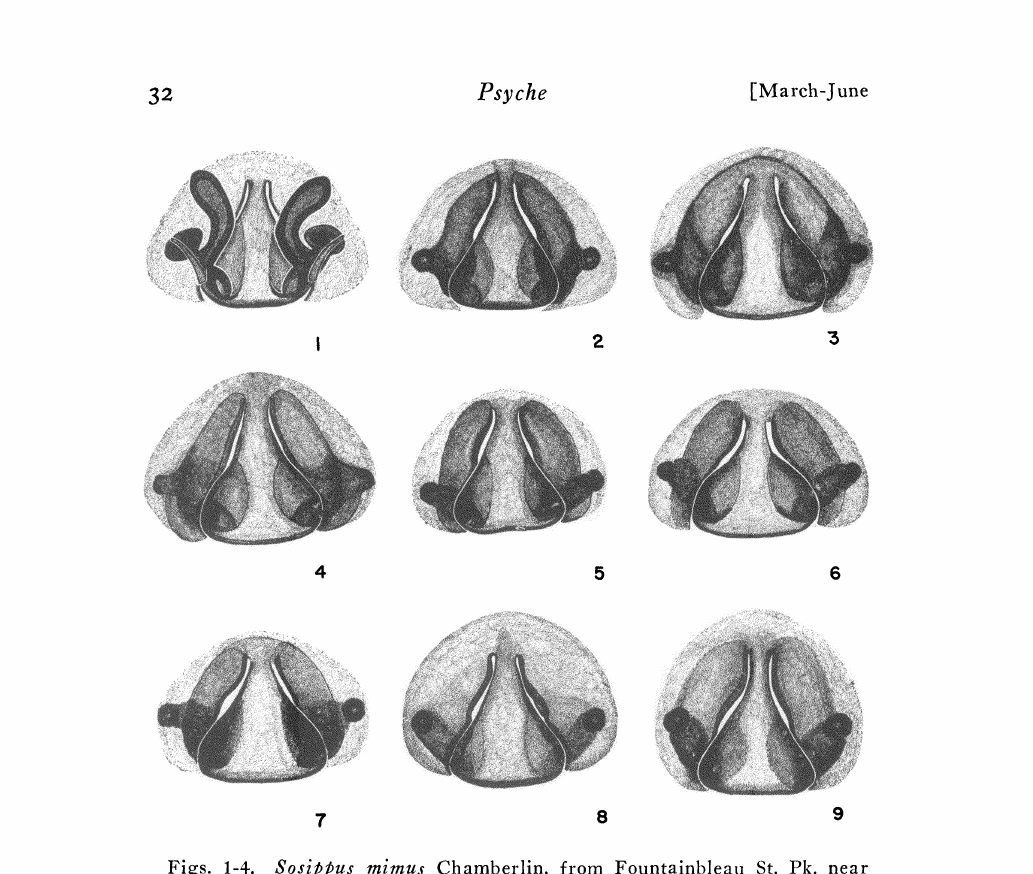
Figs. 1-4. Sosippus mimus Chamberlin, from Fountainbleau St. Pk. near Mandeville, St. Tammany Par., Louisiana, 17-18 June 1968. 1. Internal genitalia, dorsal view. 2-4. Epigyna, showing variation. Figs. 5-7. Epigyna of Sosippus mimus Chamberlin from Magnolia St. Pk. near Biloxi, Jackson Co., Mississippi, 18 June 1968, showing variation. Figs. 8-9. Epigyna of Sosippus mimus Chamberlin from 7 mi. S. of Youngstown, Bay Co., Florida, 20 June 1968, showing